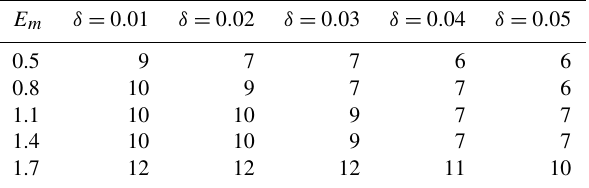
Table 10. Incorrect ratio in all 40 LBMPTs yielded by